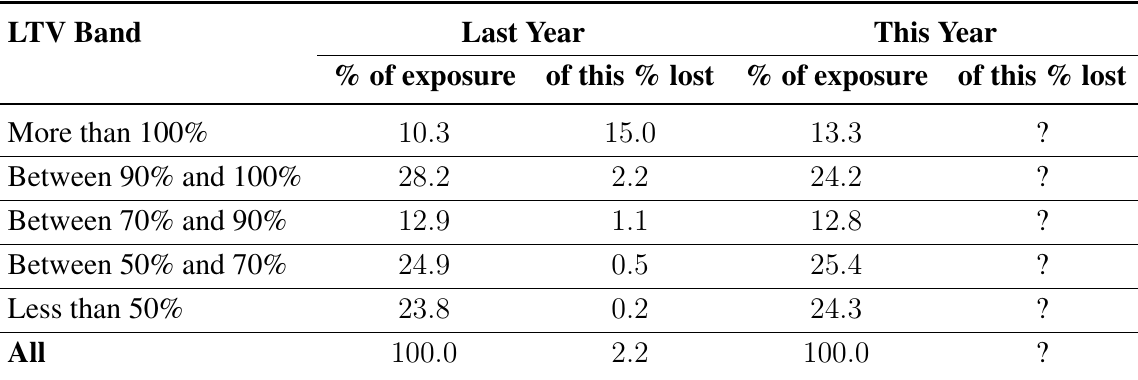
Table 1. Fictitious report on mortgage portfolio exposure distribution and loss